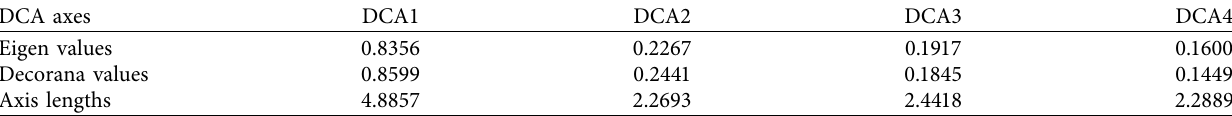
Table 3: Detrended correspondence analysis result of MFBR